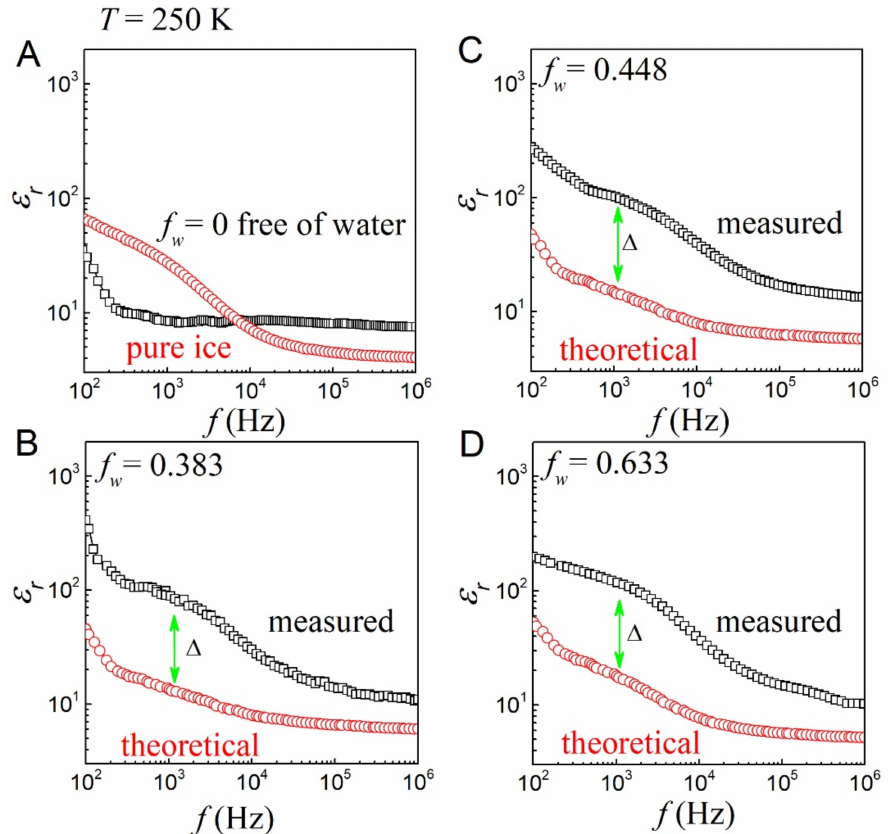
Figure 4. Dielectric constant ε r ( f ) vs. frequency ( f ) curves for all hydrogels at T = 250 K. ( A ) ε r ( f ) curves of pure ice and dry chitosan-hydrogels. ( B – D ) Measured permittivity ε r ( f ) (black open squares) and theoretical permittivity ε r ( f ) (red open circles) for the hydrogels with f w of 0.383, 0.448, and 0.633, where the symbols ∆ represent the difference between the measured and theoretical permittivity ε r ( f ) in the low and mid frequency